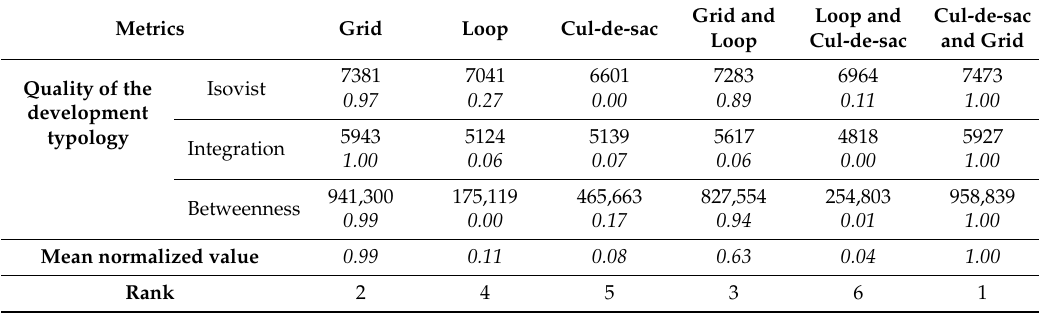
Table 3. Calculation of the quality of development for each typology and their min–max normalized values .